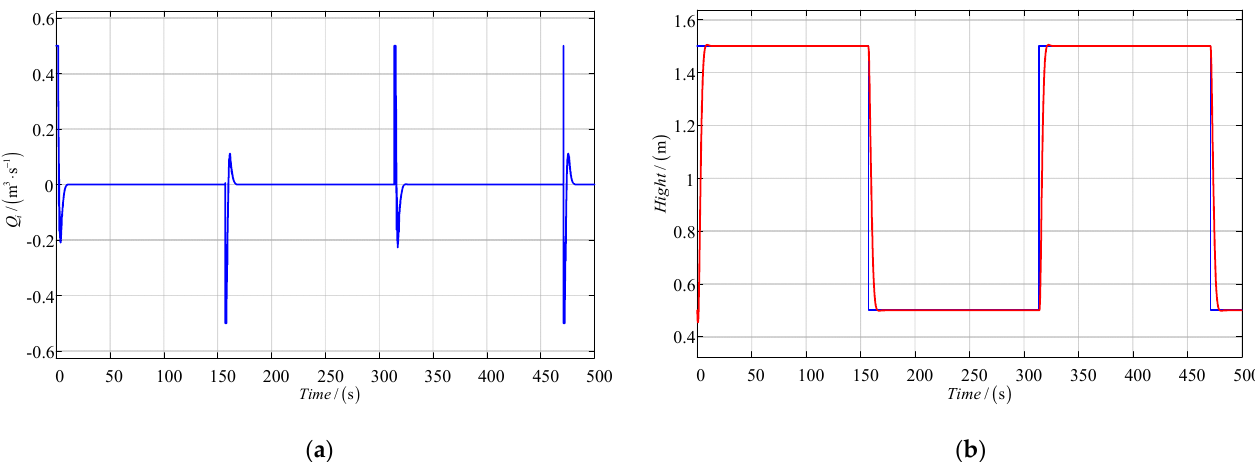
Figure 7. Simulation results of nonlinear feedback: ( a ) represents the control input curve ( b ) represents the water level curve.